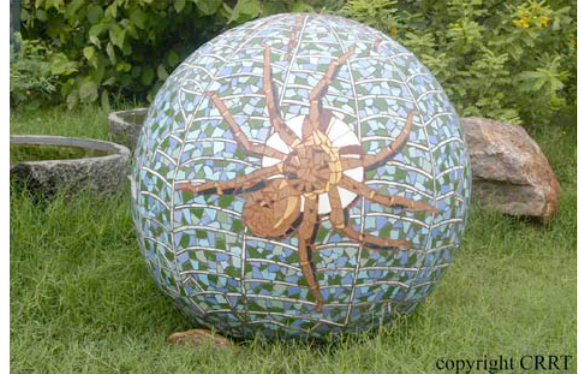
Image 16. A mosaic of a Giant Crab Spider Heteropoda venatoria holding its egg case adorns a ball approximately 1m in diameter. Tholkappia Poonga,